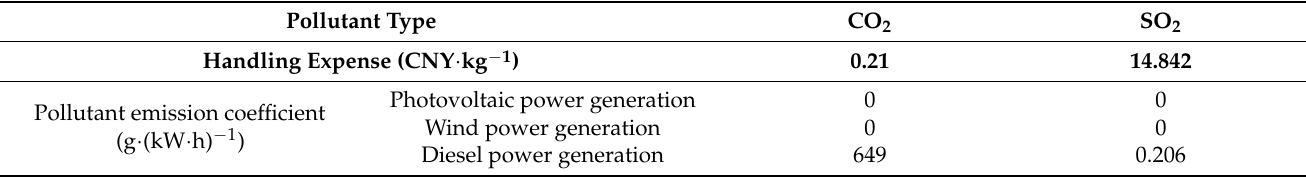
Table 3. Pollutant emission coefficient generated by each distributed generation.